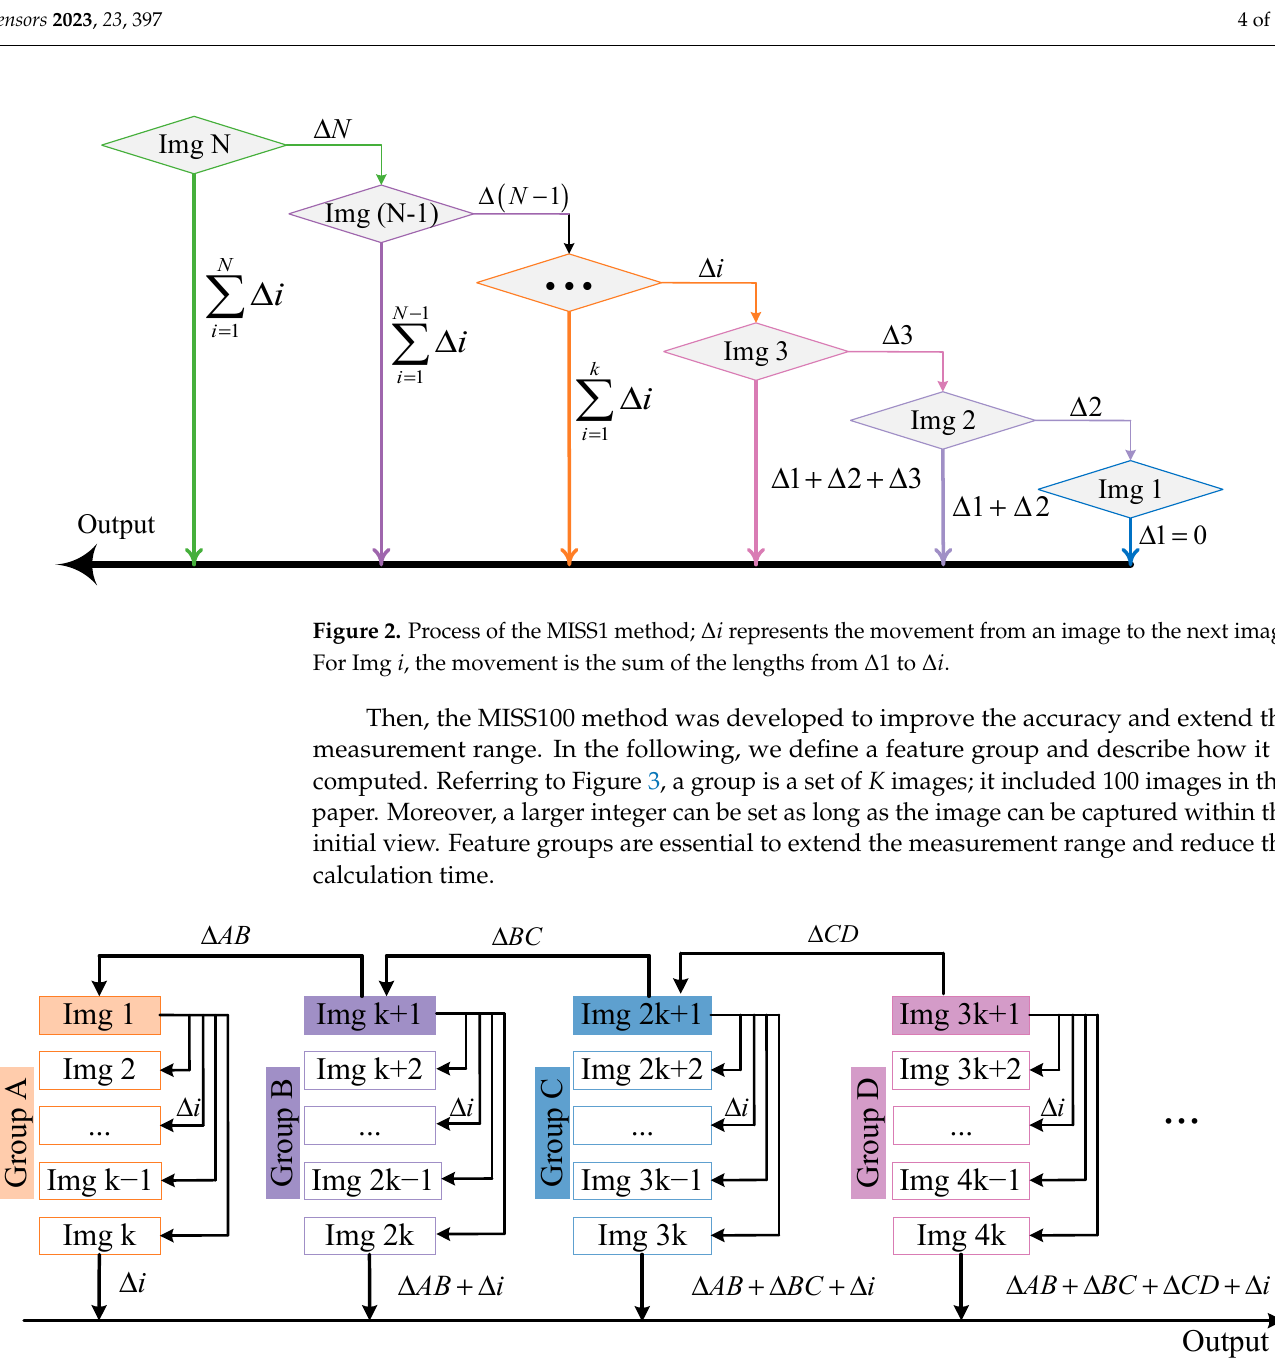
Figure 3. Process of the MISS100 method. Here, ∆𝑖 represents the movement from an image to the reference image in a feature group.